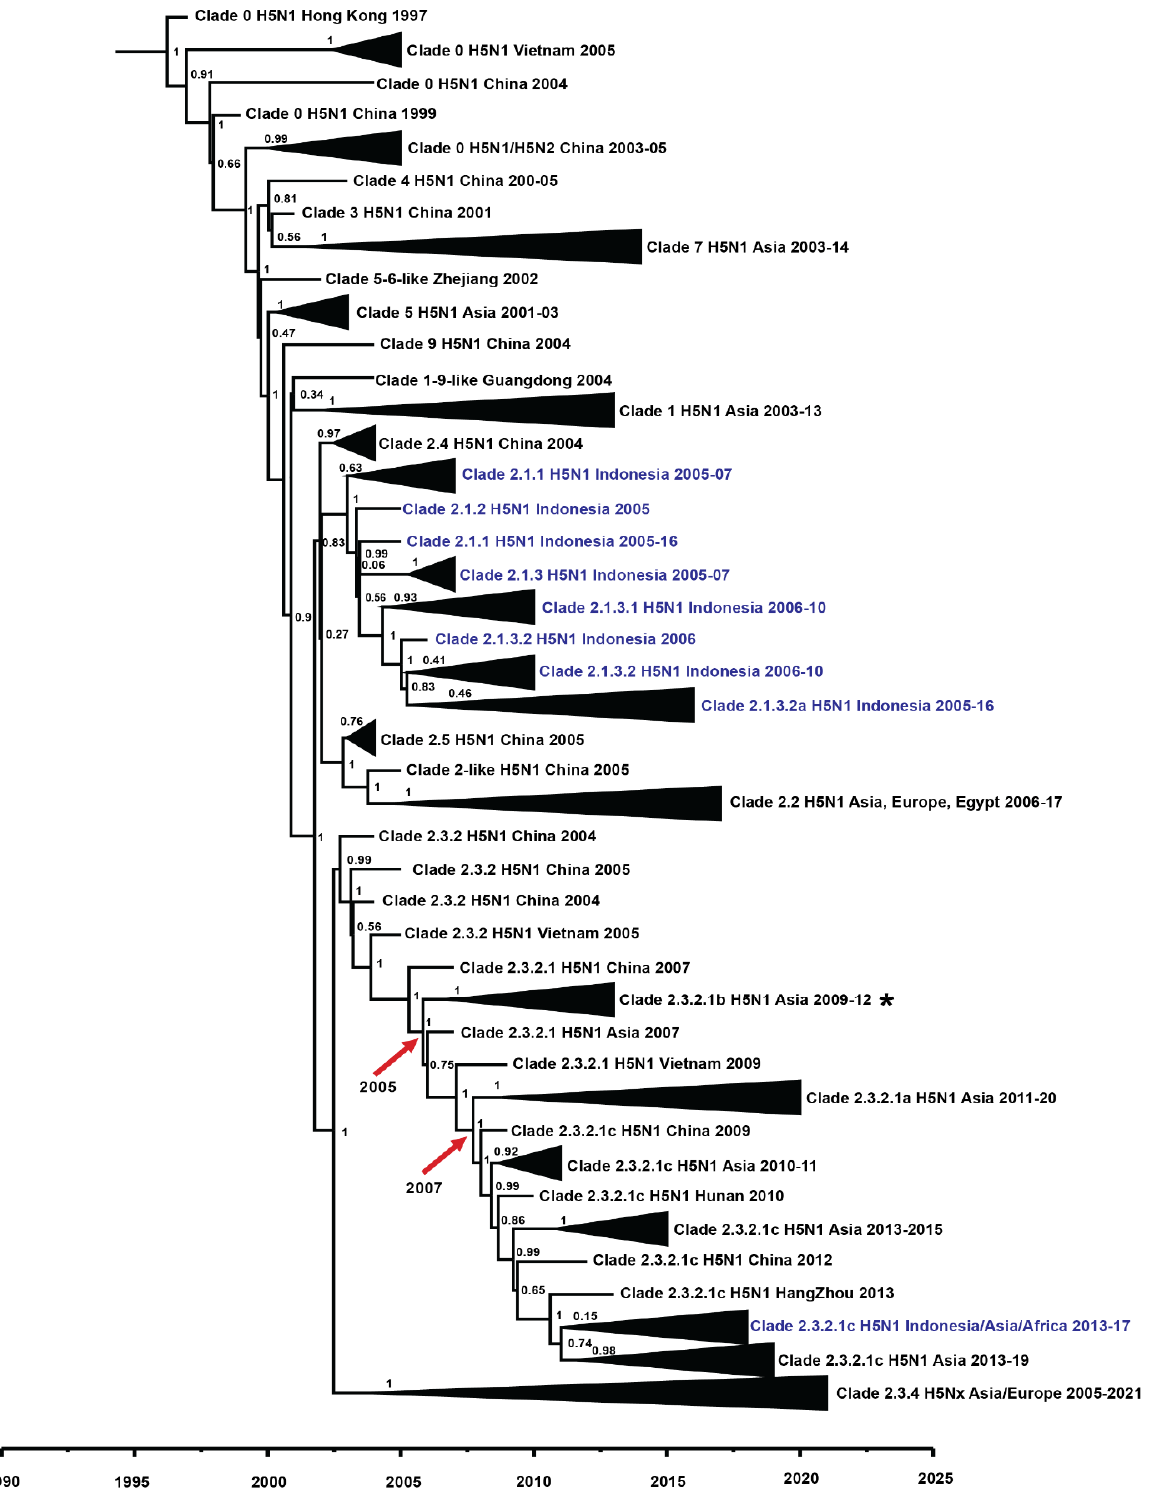
Figure 1. Time-scale phylogeny of selected worldwide HA of H5N1v. The estimated origin of the divergence of the HA 2.3.2.1c clade is highlighted in the asterisk symbol. The tMRCA of HA clades 2.3.2.1b and 2.2.3.1a are pointed out by the arrow. The blue colour highlights the HA of H5N1v from Indonesia. The node labels display the posterior value. The original sequences (GISAID ID) for worldwide HA of H5N1v phylogeny are displayed in Supplementary Table S1.